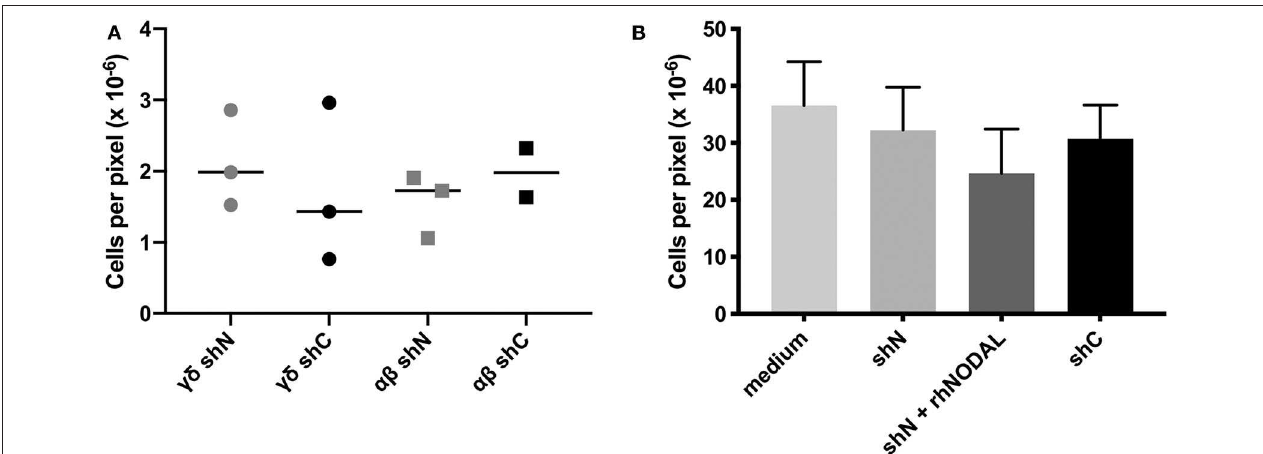
FIGURE 2 | The NODAL-positive breast cancer cell secretome has no influence on γδ T cell migration. (A) No significant difference in migration of αβ and γδ T cells toward shN and shC plated in complete medium with 20,000T cells in the top and 60,000 MDA-MB-231 cells in complete medium in the bottom chamber. Individual technical replicates are shown. (B) Compiled data from four independent V δ 1 migration assays toward medium or conditioned medium without or containing recombinant human NODAL (rhNODAL). Error bars are SEM.